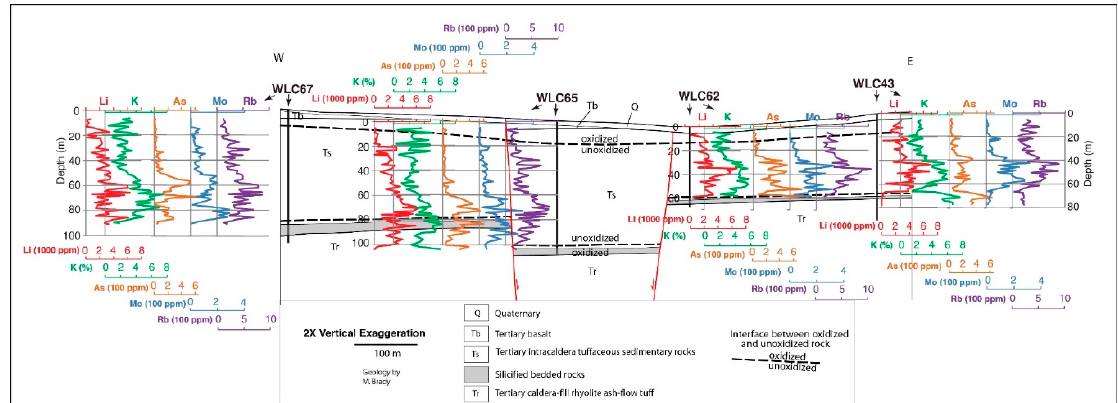
Figure 6. Fence diagram of drill holes with mineral zones. 2011 pit outline and drill hole locations are from Lithium Nevada’s Thacker Pass Project (Figure 5). Hole collar locations are in the same horizontal plane as the pit outline.